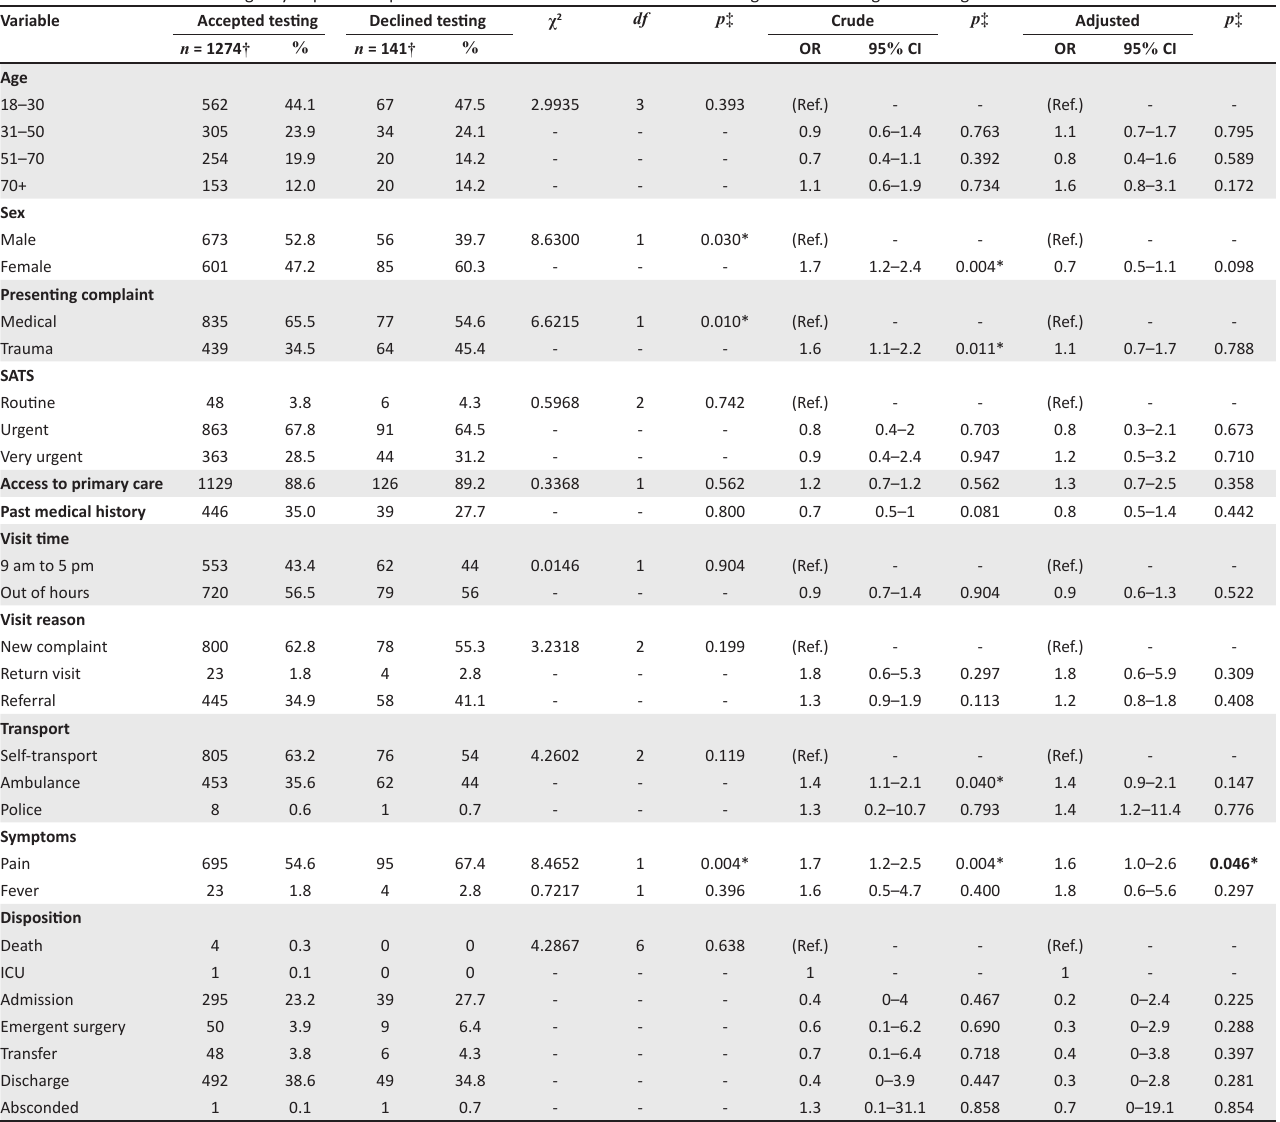
TABLE 2 : Characteristics of emergency department patients and association of factors with declining HIV counselling and testing. Variable